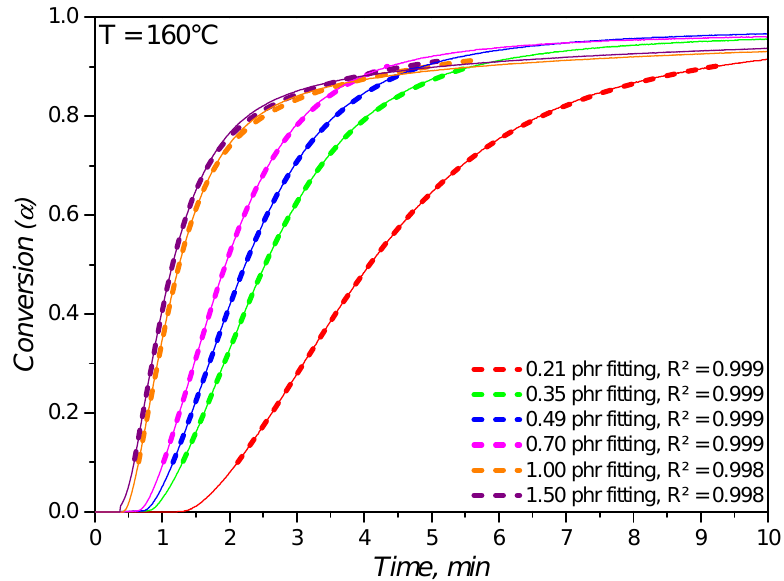
Figure 5. Comparison between the experimental and the calculated conversion values for the crosslinking at 160 ◦ C for silicone rubber compounds with dicumylperoxide concentrations. The calculated conversion values are plotted from 0.1 to 0.9 of